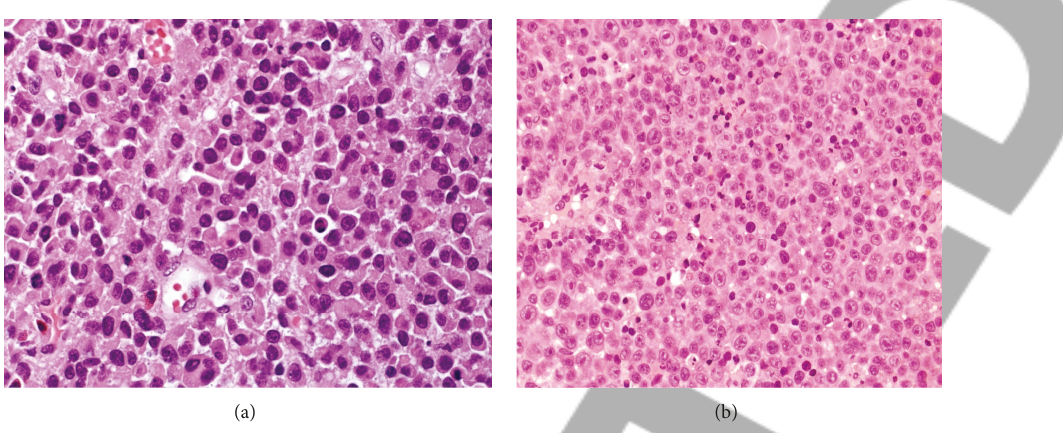
Figure 1: Histopathologic features of PBL: (a) H&E stain shows sheets of large atypical lymphoid cells with plasmacytic differentiation with abundant cytoplasm, paranuclear hof, and large nuclei; (b) it displays large cells with an immunoblastic appearance, with central oval nuclei with prominent nucleoli and moderately abundant